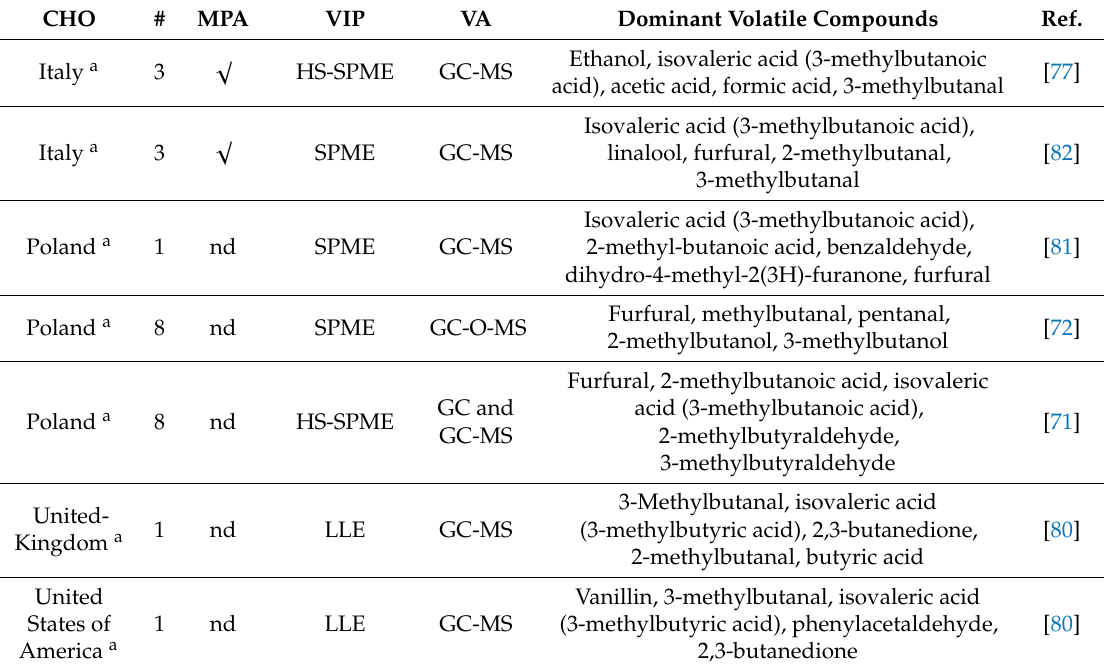
Table 3. Buckwheat honey’s main volatiles, with reference to the country of origin, number of samples, isolation and analysis procedures and five main volatile components. Unless otherwise specified, the honeybee type was A. mellifera .